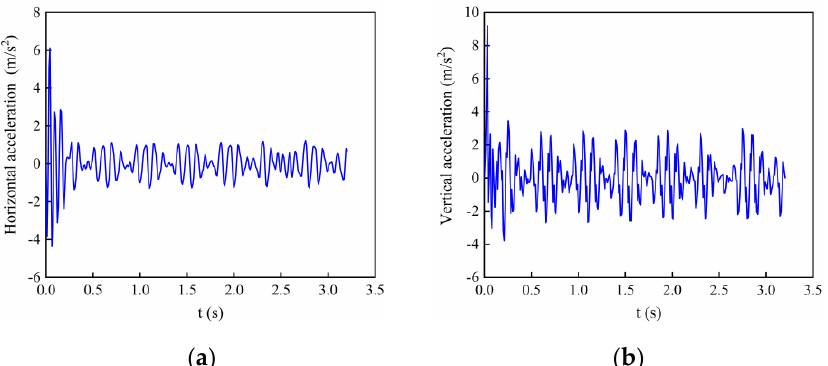
Figure 19. Acceleration response of middle partition wall measuring point: ( a ) horizontal accelera- tion response of C3 during single-train traffic; ( b ) vertical acceleration response of C5 during double-train traffic.